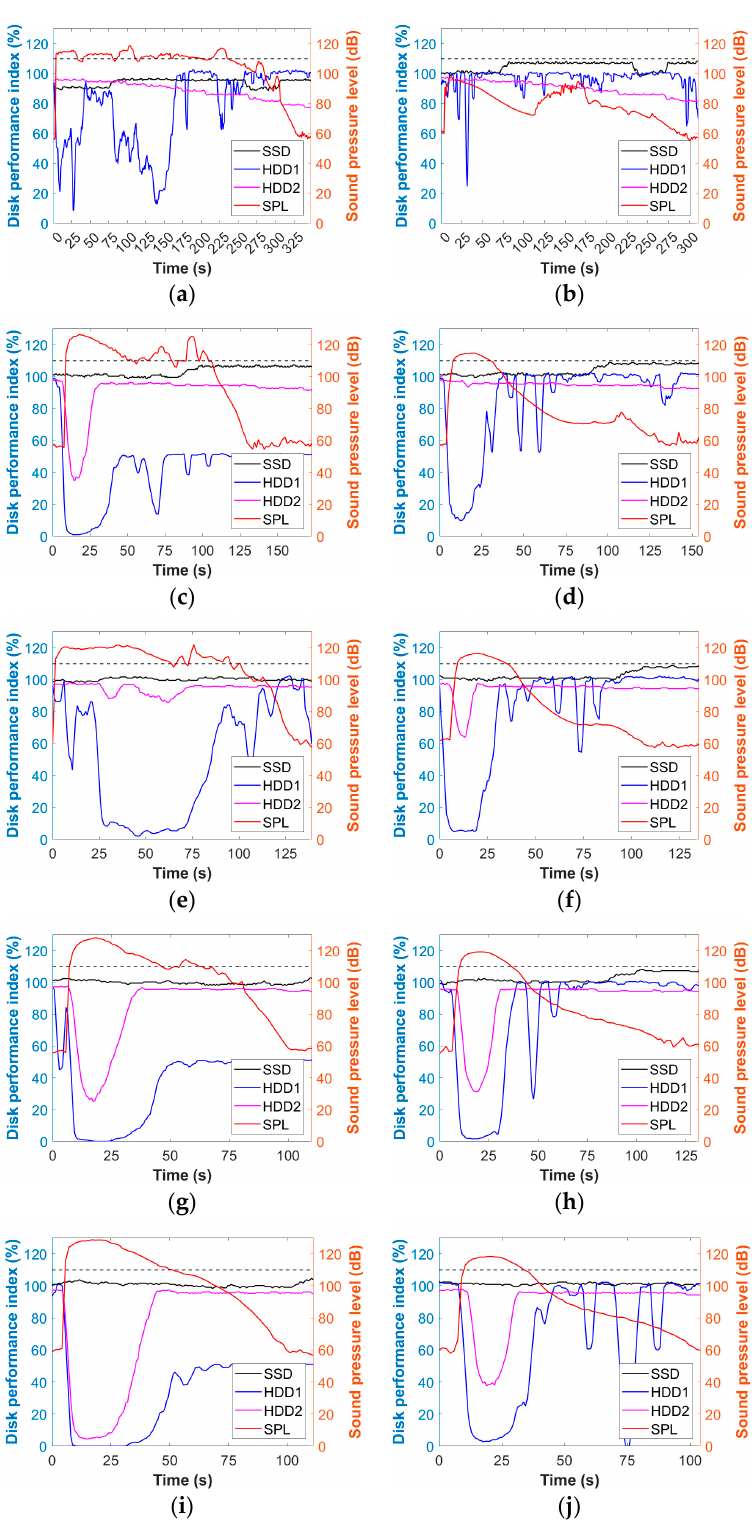
Figure 7. SPL and disk performance index as a function of time throughout a nitrogen IG100 discharge by ( a ) standard and ( b ) silent nozzle with 5 mm orifice diameter; ( c ) standard and ( d ) silent nozzle with 10 mm orifice diameter; ( e ) standard and ( f ) silent nozzle with 14 mm orifice diameter; ( g ) standard and ( h ) silent nozzle with 17 mm orifice diameter; ( i ) standard and ( j ) silent nozzle with 23 mm orifice